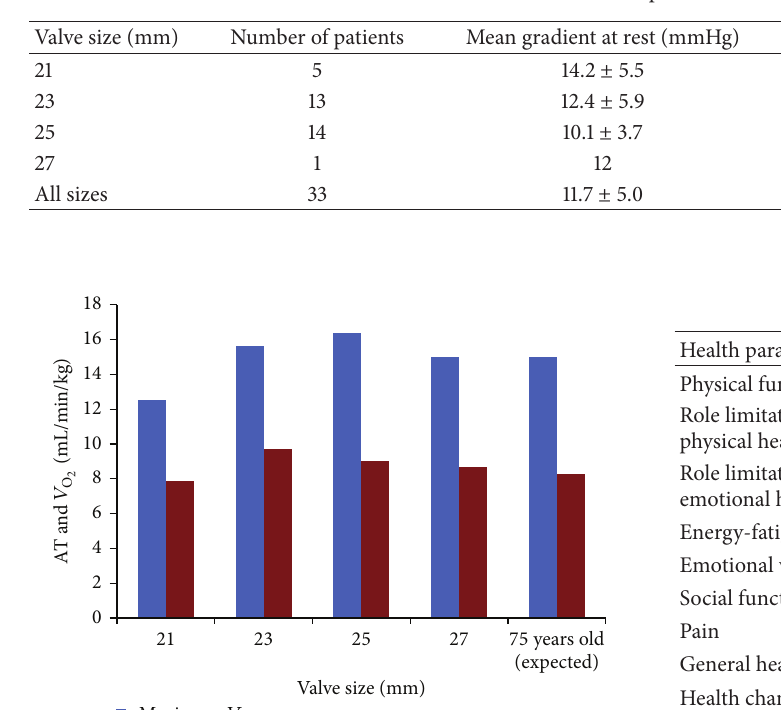
Table 2: Post-op ECHO results.